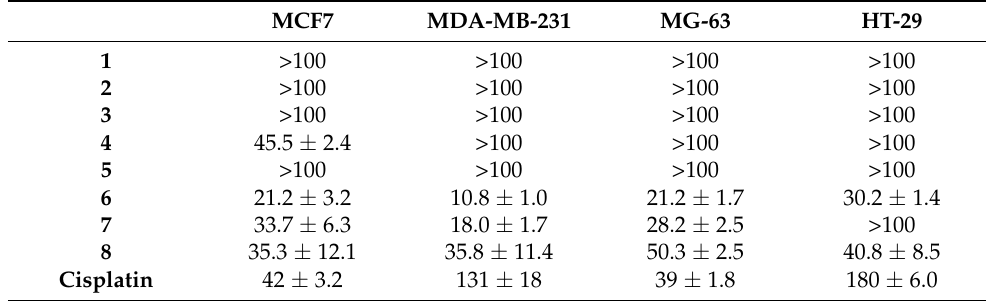
Table 2. IC 50 ( µ M) ± SD values of 1 – 8 and CDDP on MCF7, MDA-MB-231, MG-63, and HT-29 cell lines after 24 h of